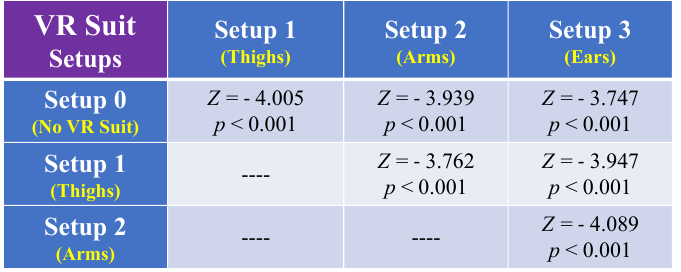
Figure 8. Wilcoxon test results on average discomfort level between each pair of setups.